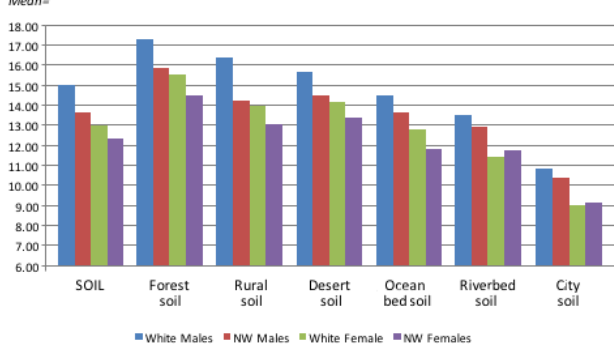
Fig. 3 . Perceived resilience of soil across ecotypes by gender and race. All males consistently regard the resilience of air, water, and soil across all ecotypes as more resilient than do all nonwhite and white